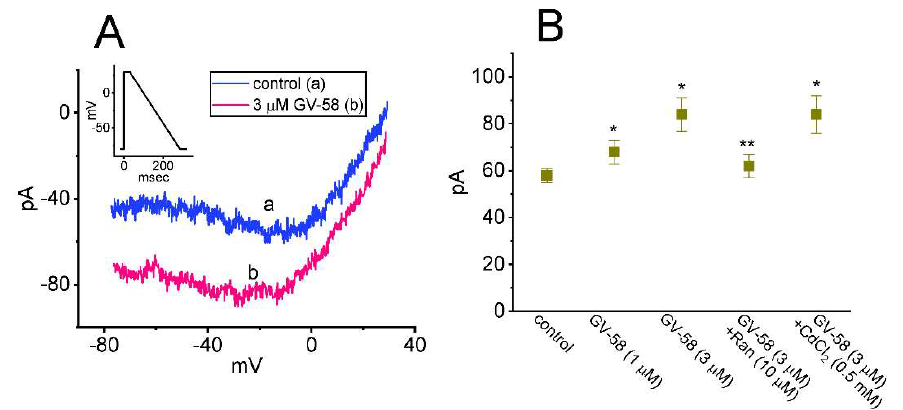
Figure 7. Effect of GV − 58 on resurgent I Na ( I Na(R) ) activated by the downsloping ramp pulse. This set of measurements was conducted in cells bathed in Ca 2+ − free Tyrode’s solution, and we filled up the electrode with Cs + − enriched solution. The examined cell was voltage − clamped at −80 mV and the depolarizing pulse to +30 mV for 30 ms; thereafter, a slowly descending ramp from +30 to −80 mV with a duration of 300 ms (i.e., with a ramp slope of −0.37 mV/ms) was applied to evoke I Na(R). ( A ) Representative current traces obtained in the control period (a) and during cell exposure to 3 μM GV − 58 (b). Inset shows the voltage − clamp protocol delivered. ( B ) Summary graph showing effect of GV − 58, GV − 58 plus ranolazine (Ran), and GV − 58 plus CdCl 2 on the amplitude of I Na(R) (mean ± SEM; n = 8 for each bar). Current amplitudes were measured at the level of −20 mV. Of notice, in the continued presence of GV − 58, subsequent application of ranolazine, but not of CdCl 2 , effectively suppresses I Na(R) activated by the descending ramp pulse. * Significantly different from control ( p < 0.05) and ** significantly different from GV − 58 (3 μM) alone group ( p < 0.05). Statistical analyses were performed by one − way ANOVA among different groups ( p < 0.05).